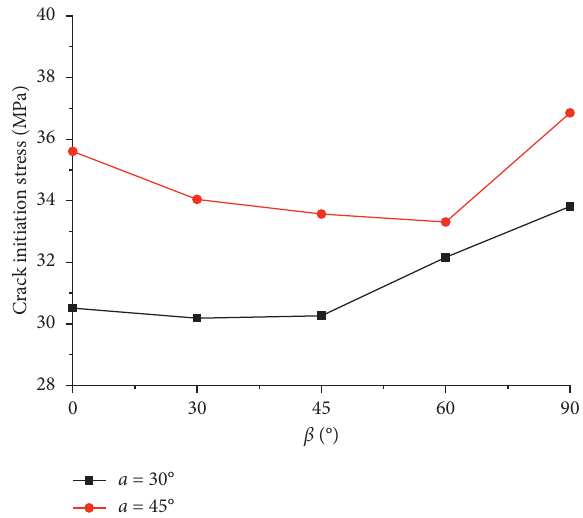
Figure 8: Variations of crack initiation stresses with β